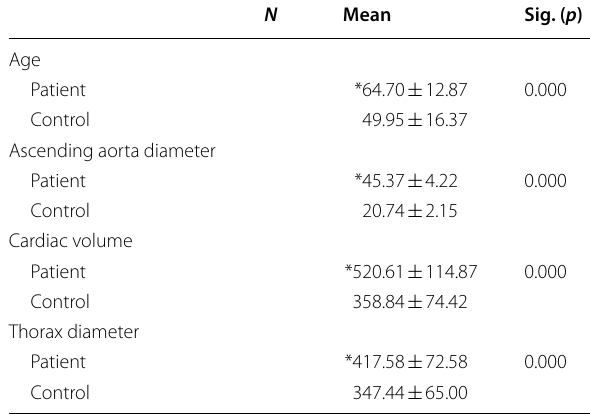
Table 1 Relation between gender and aneurysm (Pearson Chi- square)